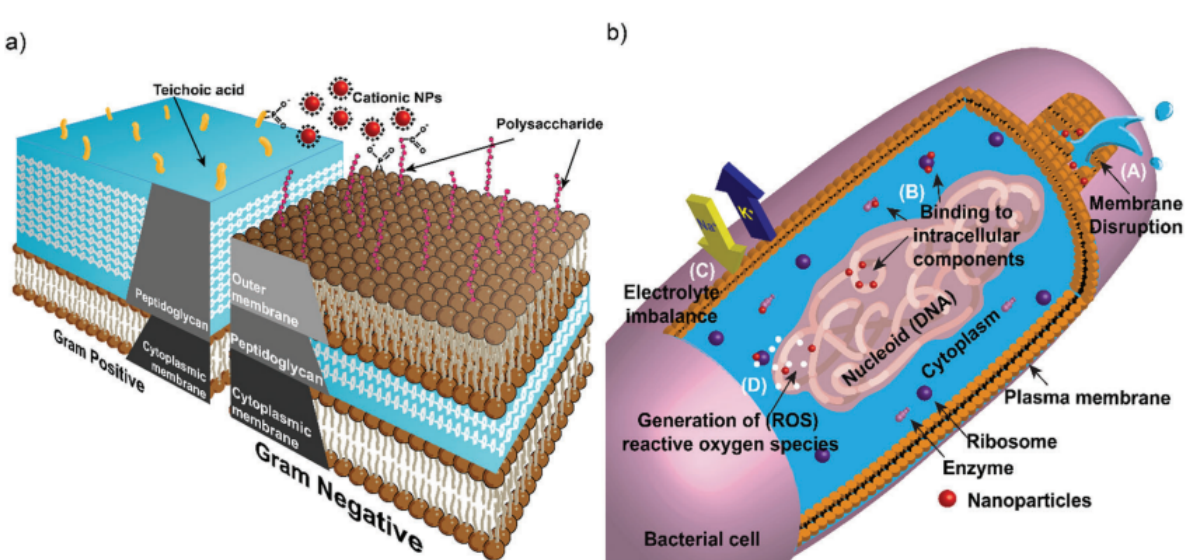
Figure 4. Graphic representation showing: ( a ) cell wall structures of gram-positive and gram-negative bacteria. ( b ) Antibacterial mechanism of nanoparticles. (A) Cell membrane is disrupted, leading to cell leakage. (B) Nanoparticles can bind to cellular components. (C) Electron transport is disrupted, thereby leading to electrolyte imbalance. (D) Reactive oxygen species are generated. Reproduced from Gupta et al. [74] with permission from the Royal Society of Chemistry.